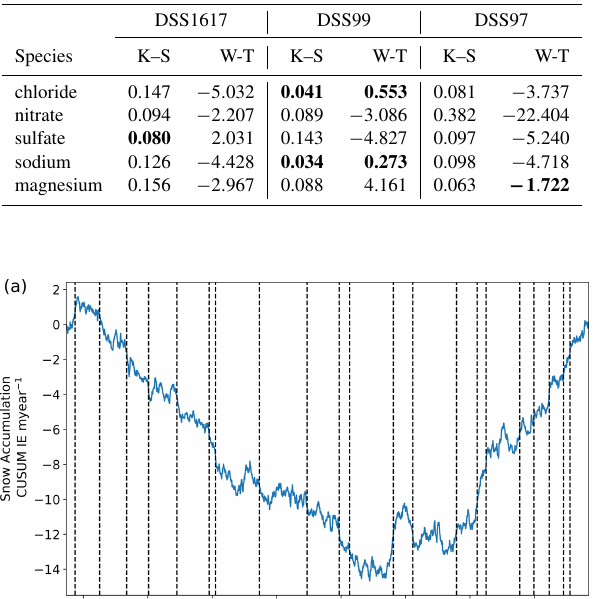
Table B1. Statistical comparison between DSSMain and the shorter DSS97, DSS99 and DSS1617 cores that make up the composite. Tests are performed between segments from cores with the closest average value of snow accumulation as calculated using the change- point analysis. D-statistics from the Kolmogorov–Smirnov (K–S) test and Welch’s t test (W-T) in bold indicate species where the p value is greater than 0.05, indicating that the null hypothesis that both samples are from the same distribution cannot be rejected and, hence, have a comparable distribution.